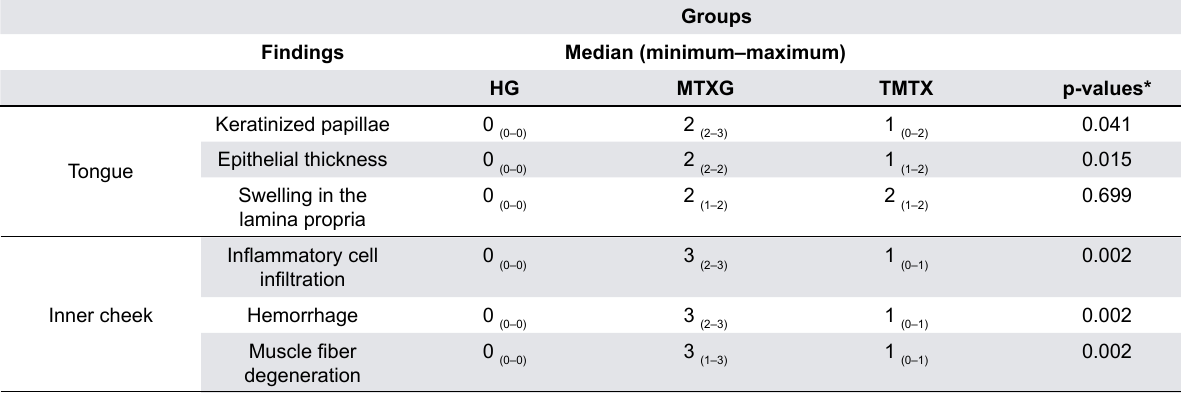
Figure 3- Histopathological evaluation of the tongue tissue in the groups. A . Tongue tissue of the healthy group. Normal histological appearance with keratinized papillae (arrow) (HxE). B . Tongue tissue of the MTX group. Thin epithelial thickness (arrow) (HxE). C . Tongue tissue of the TMTX group. Moderate epithelial thickness (arrow) and keratinized papillae (arrowhead) (HxE). D . Tongue tissue of the MTX group. Moderate swelling (*) in the lamina propria (HxE). E . Tongue tissue of the TMTX group. Moderate swelling (*) in the lamina propria. (HxE). Table 3- Histopathological damage